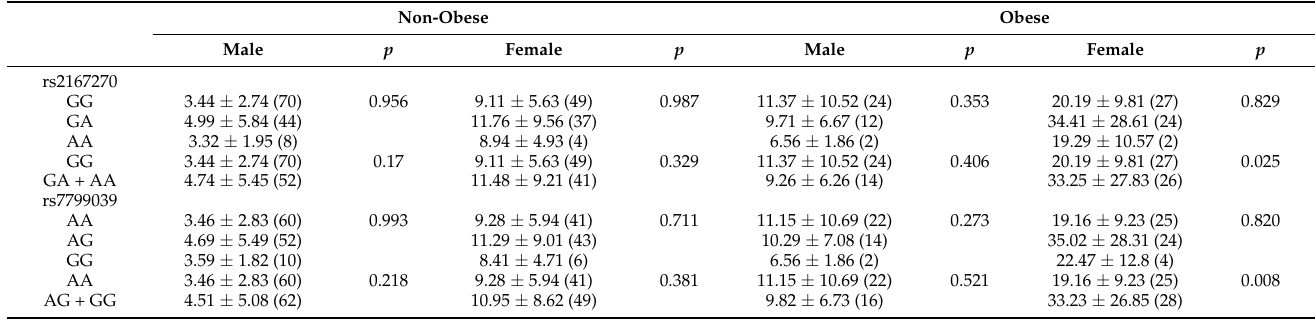
Table 4. Association between LEP SNPs and leptin levels in sex according to obesity